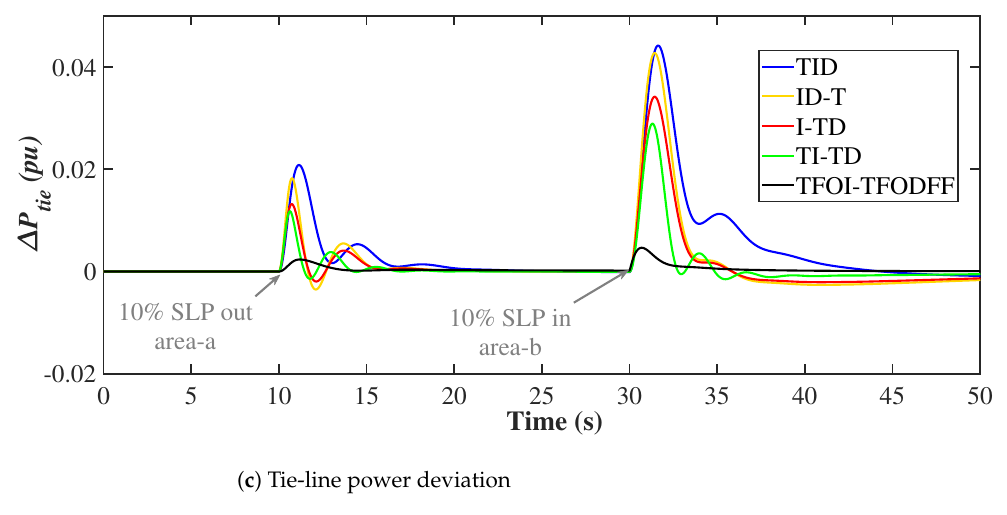
Figure 13. The dynamic response of the system for scenario